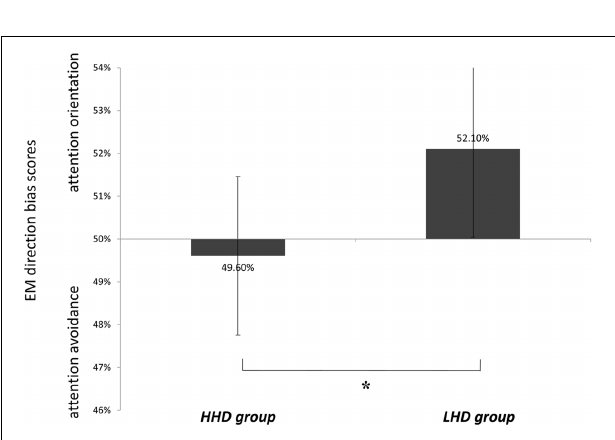
FIGURE 3 | First fixation duration bias scores among HHD group and LHD group. ∗ p <